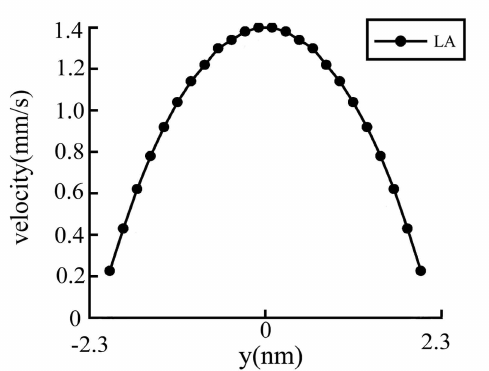
Figure 5. Poiseuille flow simulations of case 2 (low flow velocity simulations). is the result of this paper (LA